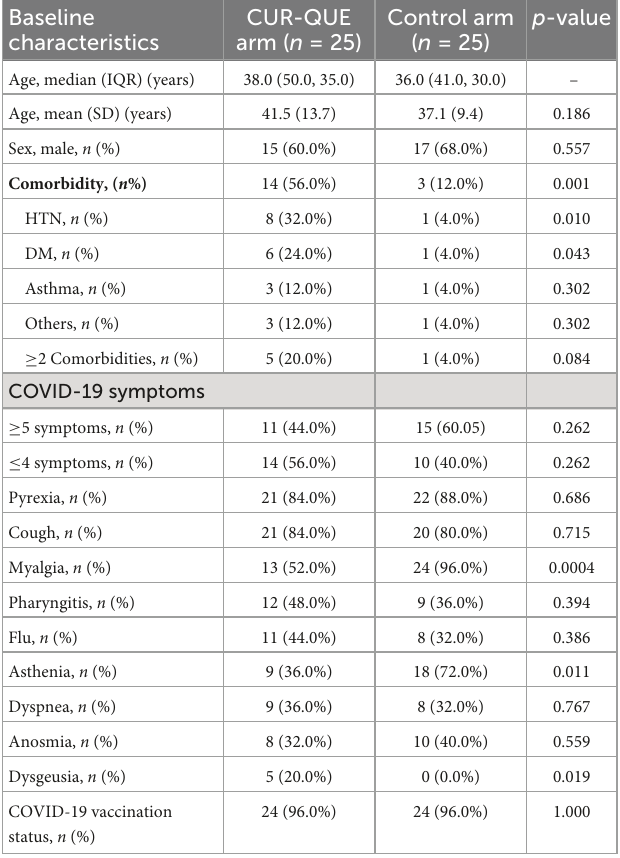
TABLE 1 Patients’ demographics and baseline clinical characteristics. Baseline characteristics